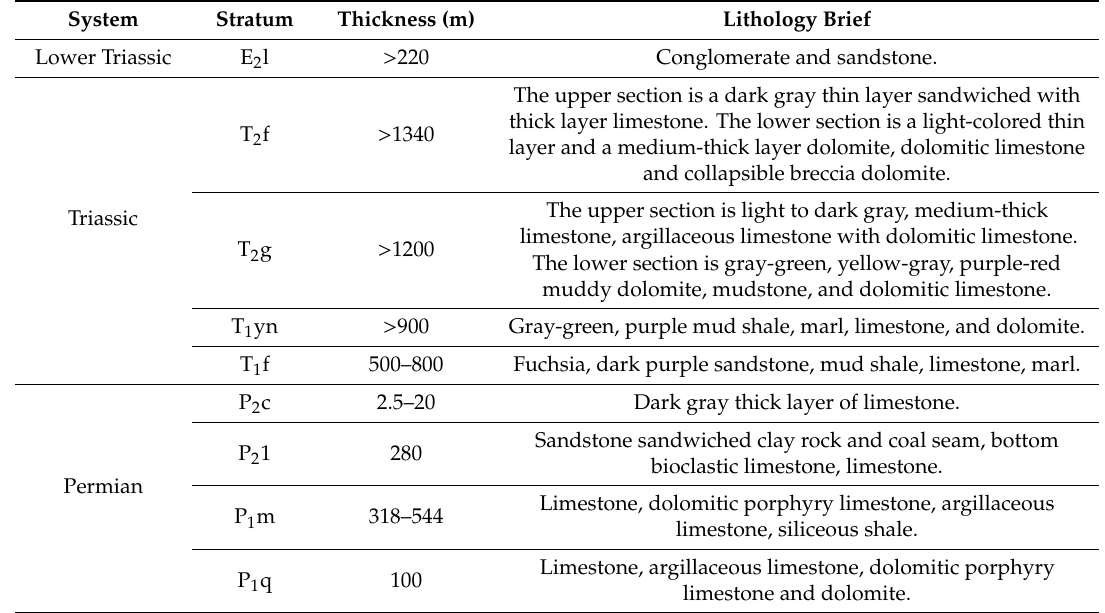
Table 2. Brief description of the regional stratum in the